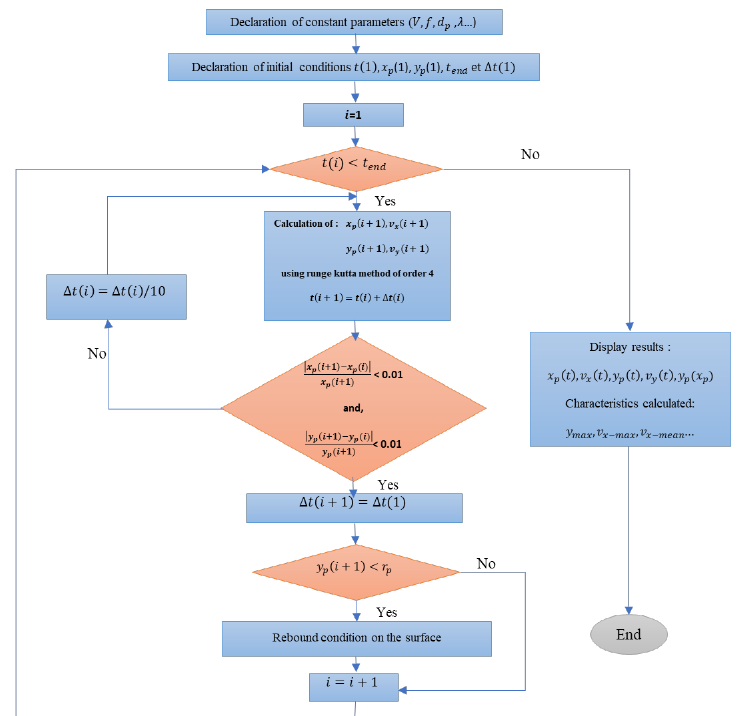
Figure 3. Algorithm used for calculating particle trajectory [36]. Table 1. Values of various parameters used during simulation.